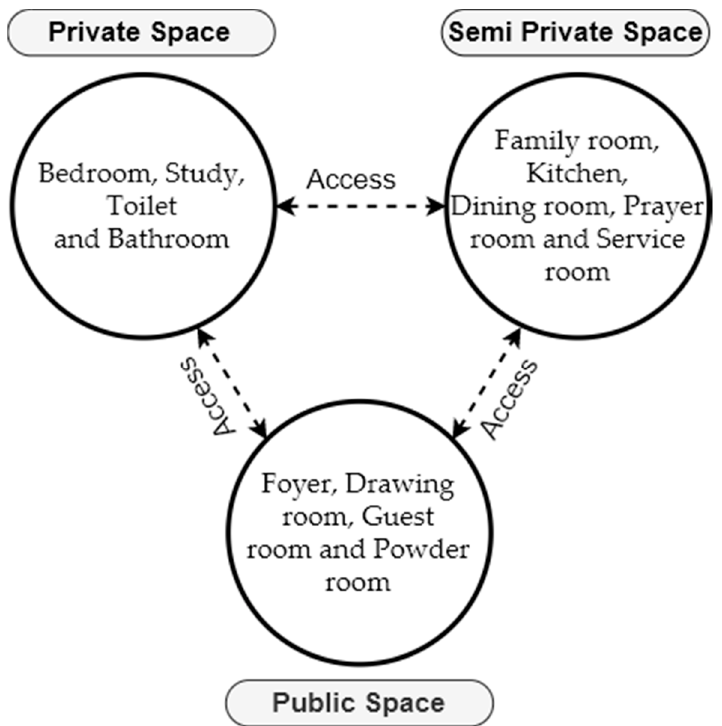
Figure 3. Spatial functions of domestic environment [13,14,20,43].